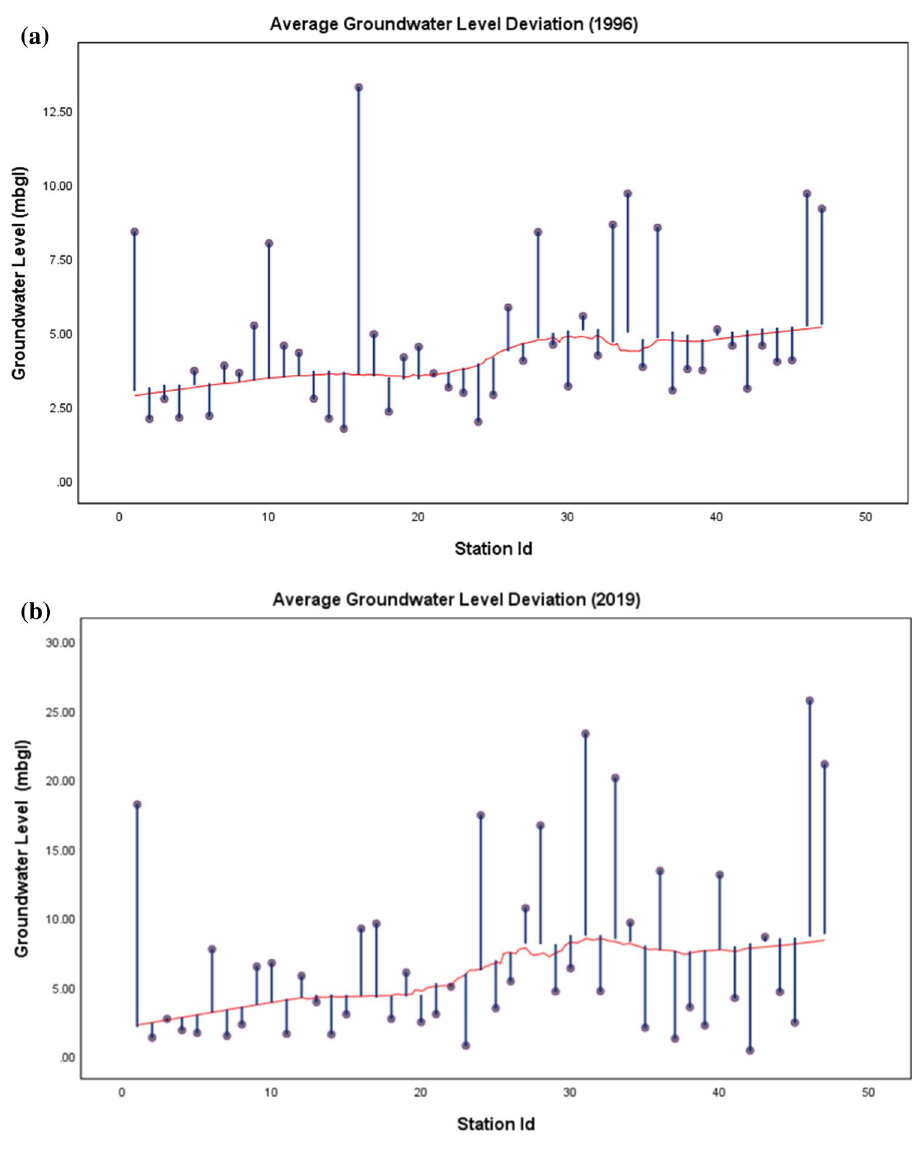
Fig. 14 a Locally weighted regression and scatterplot for groundwater level 1996. b Locally weighted regression and scatterplot for